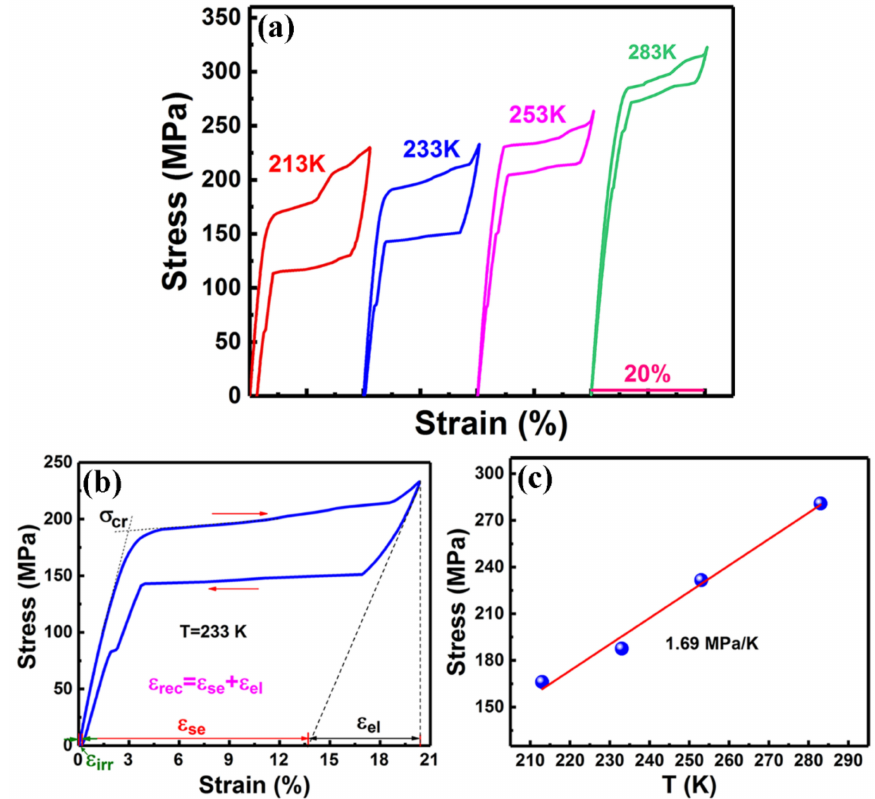
Figure 3. ( a ) Tensile stress–strain curves recorded at different constant temperatures in the range of 213–283 K for the Ni 50 Mn 34 Fe 3 In 13 microwire. ( b ) Tensile stress–strain curve measured at 233 K with the determination of the following parameters: the critical stress for stress-induced martensitic transformation σ cr , the stress hysteresis of the stress-induced martensitic transformation ∆ σ , the irrecoverable strain after unloading ε irr , the superelastic strain ε se and the elastic strain ε el . The total recoverable strain ε rec is the sum of ε se and ε el . ( c ) Temperature dependence of the critical stress for stress-induced martensitic transformation σ cr